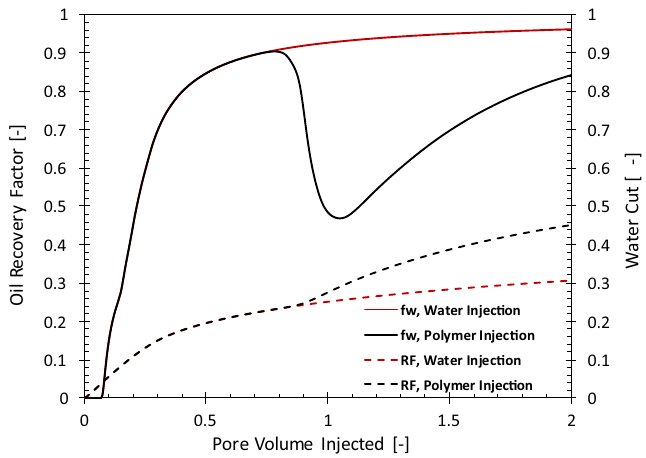
Figure 2. The oil recovery factor (RF) and water cut ( f w ) histories for water and polymer injection.